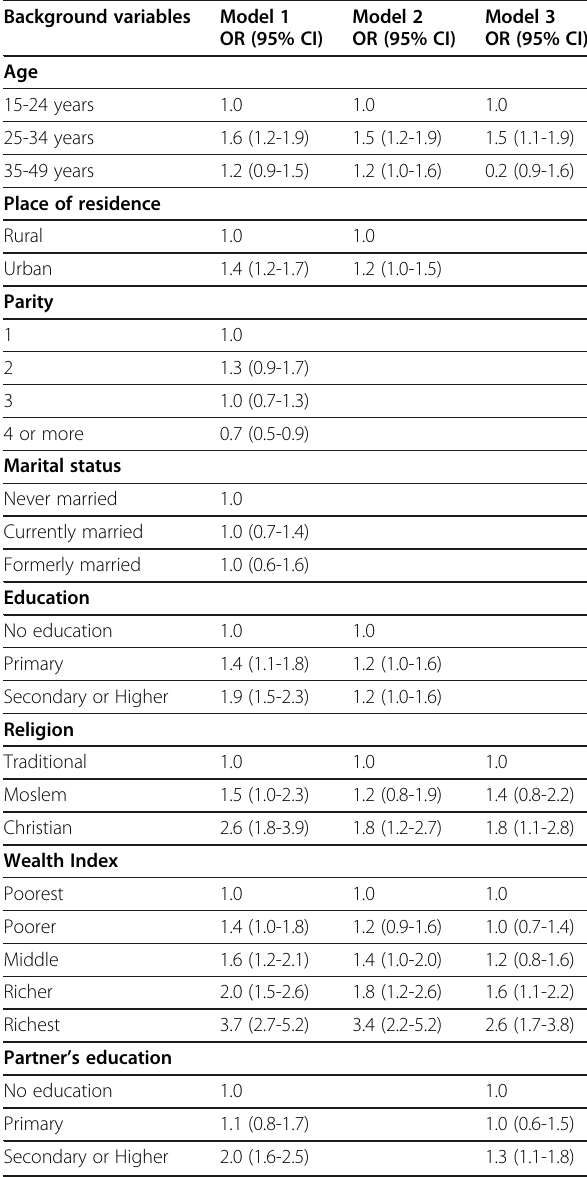
Table 2 Odds ratios (OR) and 95% confidence intervals (CI) for factors associated with early antenatal care visit among Ghanaian women in 2008